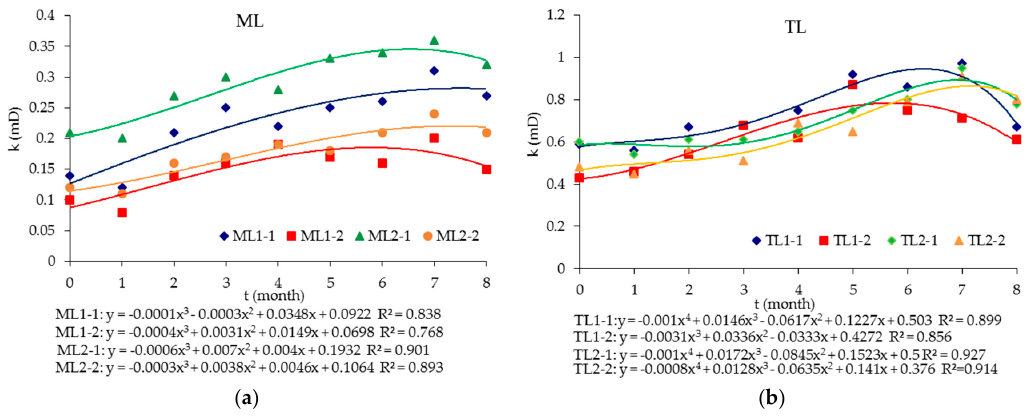
Figure 9. Permeability changes of Malan (ML) and Tunlan (TL) samples over time. The fitting formulas below dictate the permeability trends of all the samples: ( a ) ML and ( b ) TL.